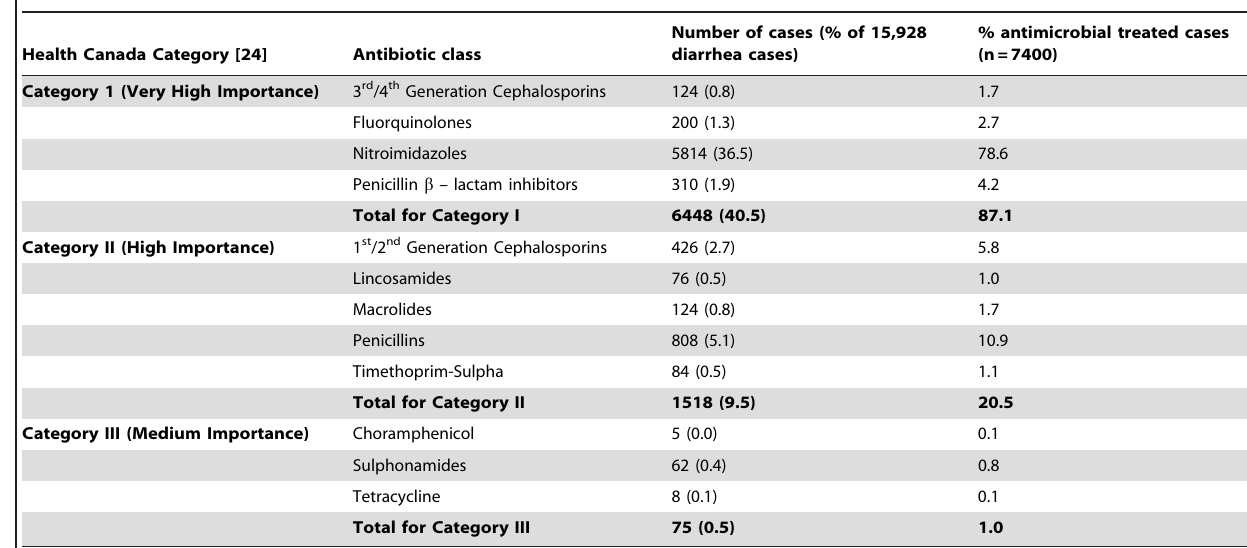
Table 5. Distribution of antimicrobials used by the veterinary practices in the treatment of companion animal diarrhea cases (n=15,928) in 2007, 2008, 2009 and